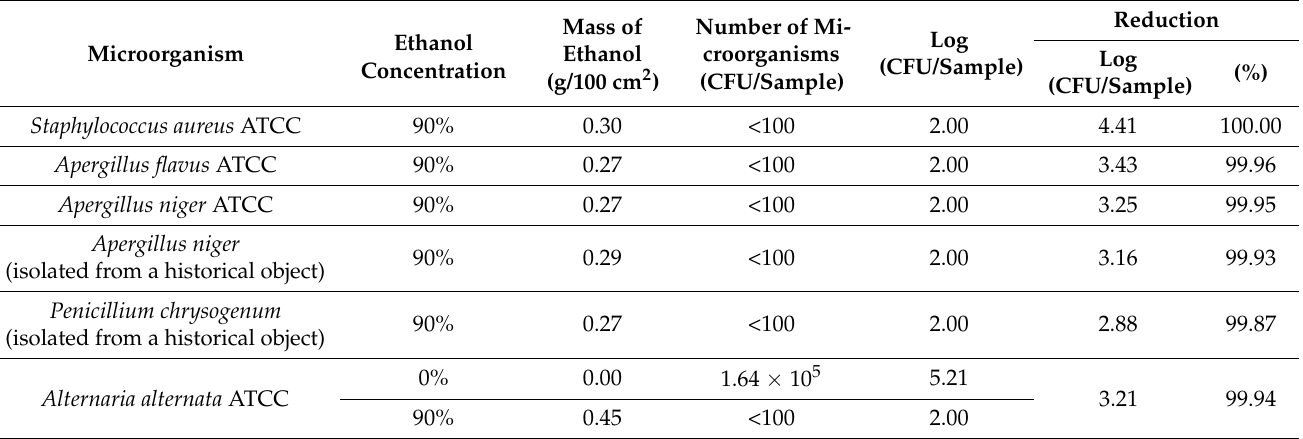
Table 5. Evaluation of the effectiveness of the long-term effect of ethanol applied for 4 s on an- tique fabrics.